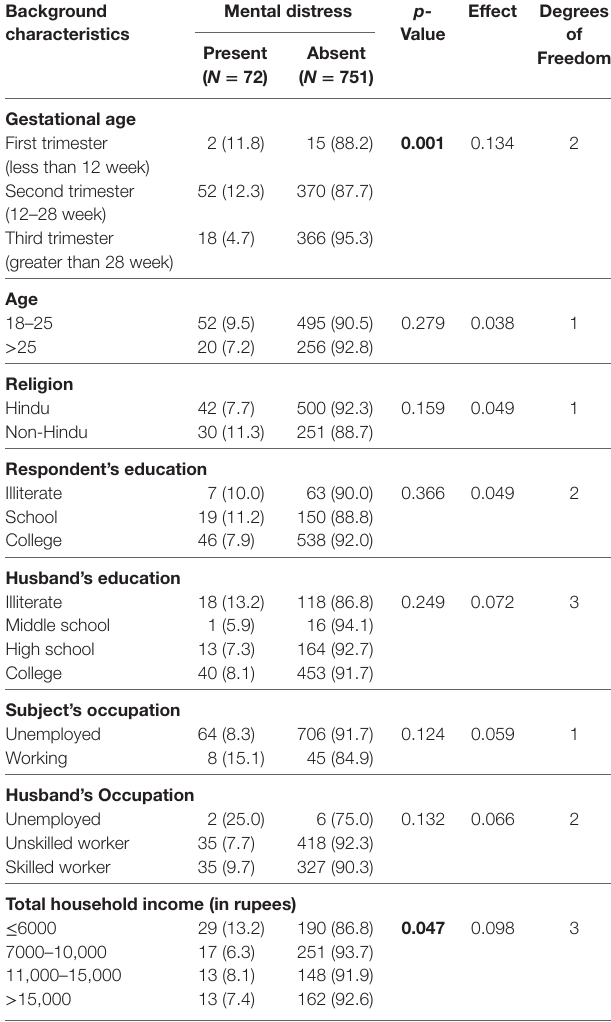
TaBle 2 | Obstetric cum medical factors and mental distress in pregnancy ( N = 823).